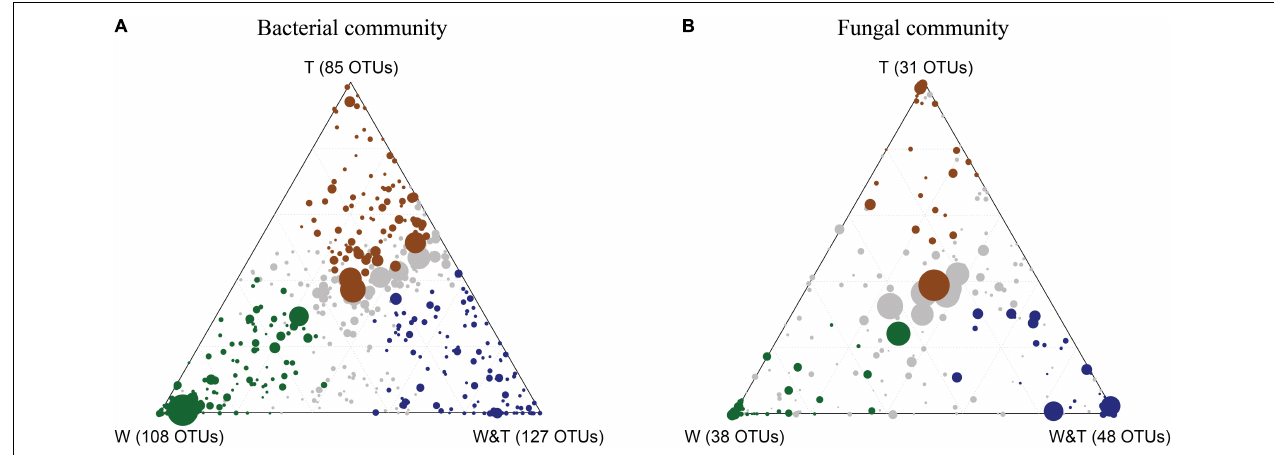
FIGURE 7 | Ternary plot showing bacterial operational taxonomic units (OTUs) (A) and fungal OTUs (B) significantly enriched in monoculture tea forest (T, brown circles), monoculture walnut forest (W, green circles), and walnut–tea intercropping forest (W&T, blue circles). Each circle represents one OTU. The size of each circle represents its RA. The position of each circle is determined by the contribution of the indicated group to total RA. Only taxa with RA > 1 were included in the